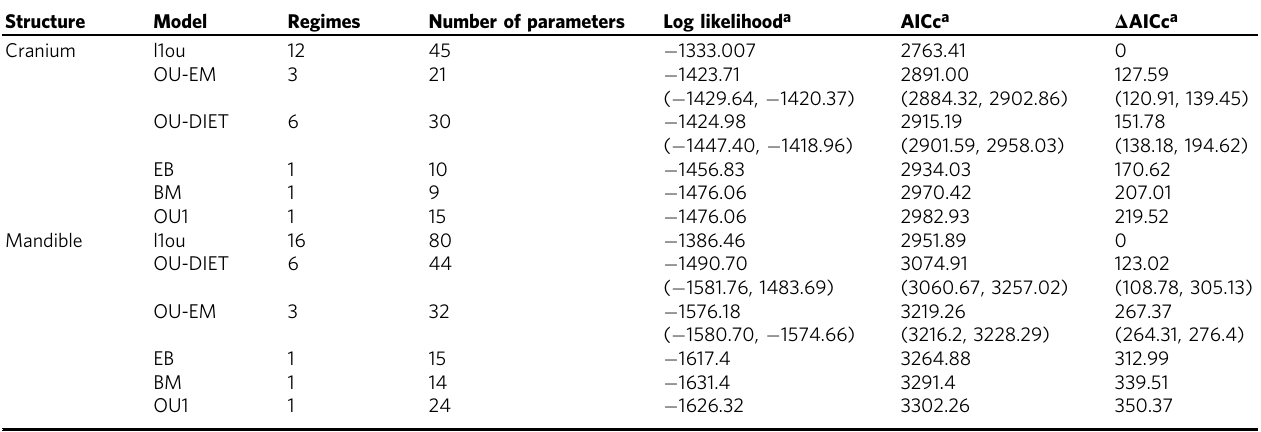
Table 1 Results of mvMorph multivariate model fi tting of cranium and mandible shape evolution across bats